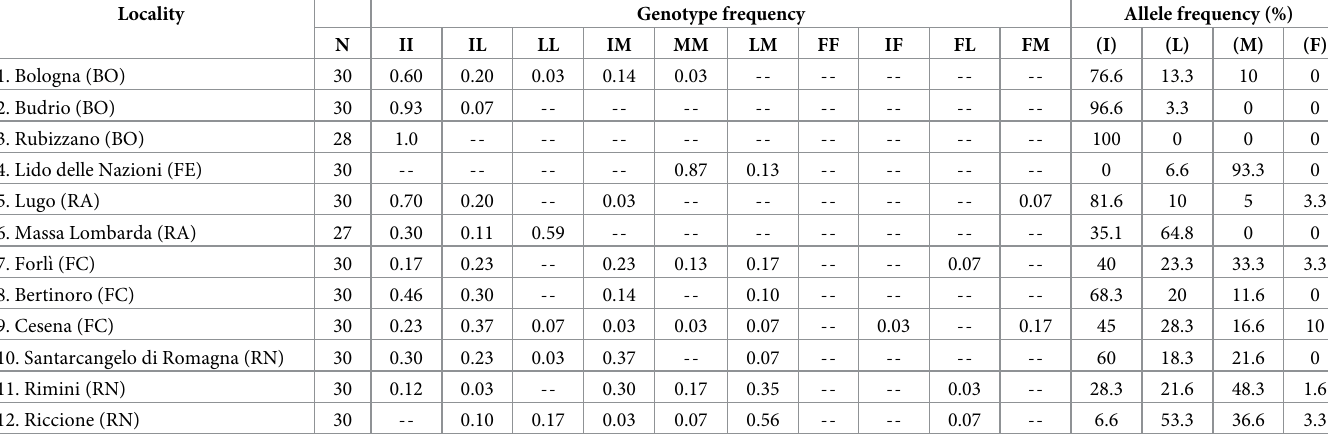
Table 1. Detection and monitoring of CHS alleles associated with DFB resistance in Cx . pipens populations from Italy sampled in 2018.